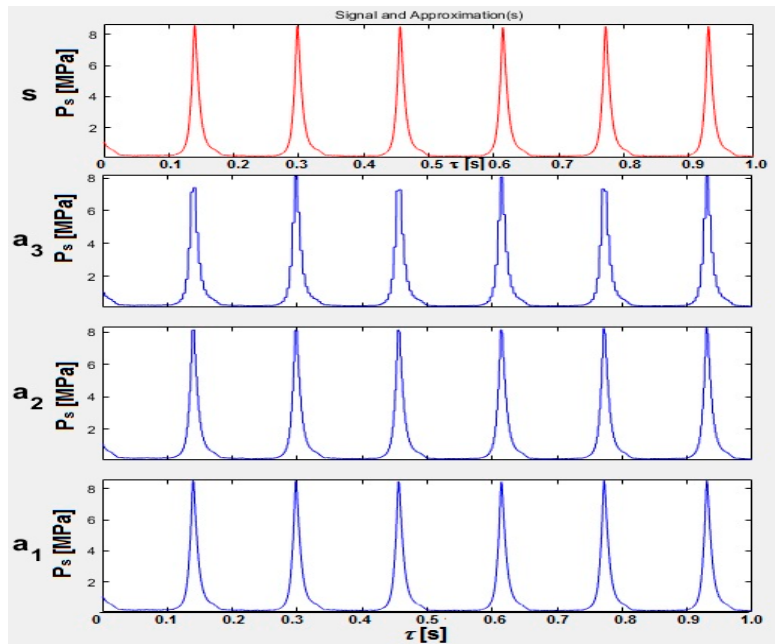
Figure 3. Fragment of the decomposition using the Daubechies wavelet (db) of the pressure waveform signal in the cylinder at decomposition level 5 in the frequency band 0–2500 Hz.